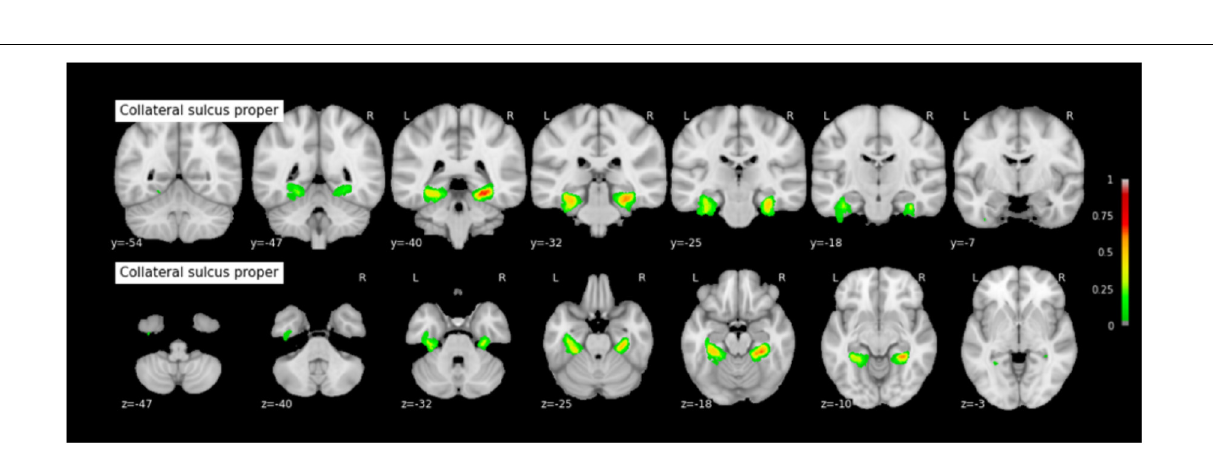
FIGURE 4 | Probabilistic map of the rhinal sulcus (RS). The maps are normalized into the MNI stereotaxic space. Coordinates are indicated on each slice. Color bars indicate the probability of presence of the structure, ranging from 0 (voxel absent in subjects) to 1 (voxel present in subjects). A 0.05 threshold was used for visualization purposes in order to get rid of potential outlier voxels and to limit the extension of the maps caused by the 3 mm Gaussian kernel smoothing.